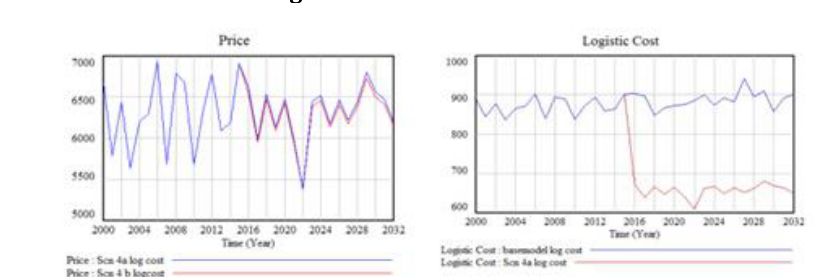
Figure 5: Scenario Result